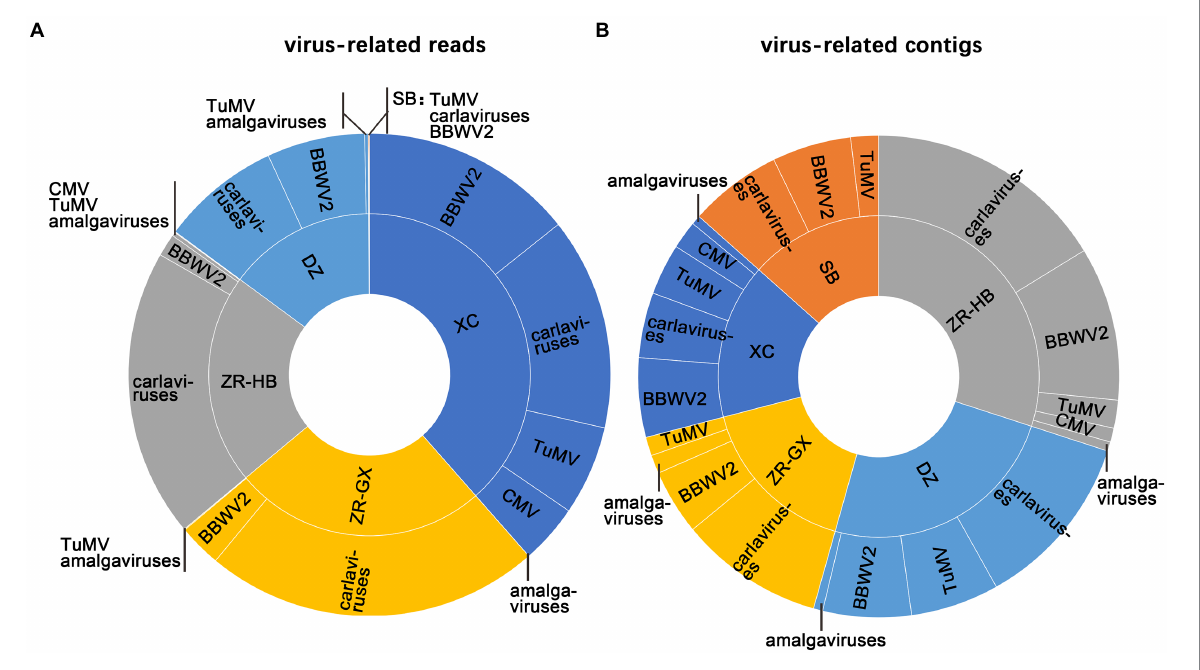
FIGURE 2 The identification of viruses in each sample. The proportion of identified viruses from all five libraries based on viral-associated reads (A) , and viral- associated contigs (B) . SB, DZ, ZR-GX, ZR-HB, and XC were library names designated based on geographical